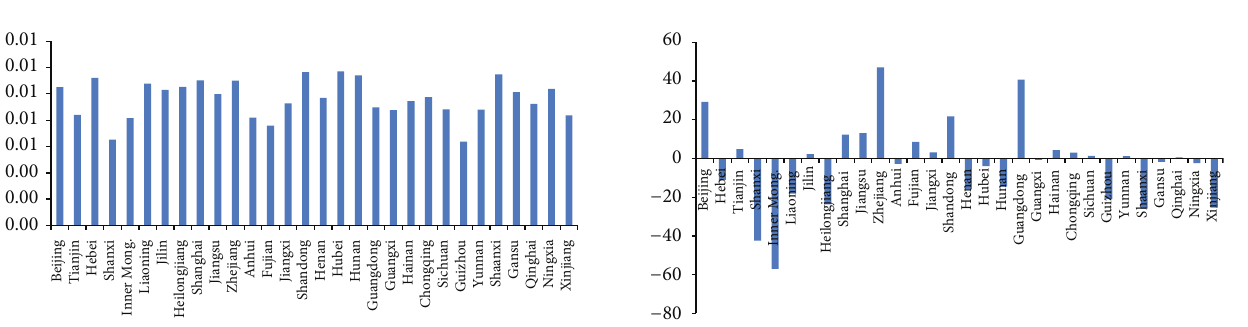
Figure 3: Net embodied energy inflow via interprovincial trade for each province in 2007 (in millions of tons of standard